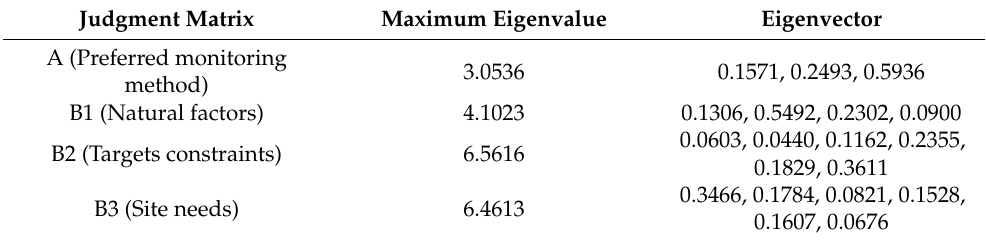
Table 2. Maximum eigenvalue and eigenvector of preferred index.